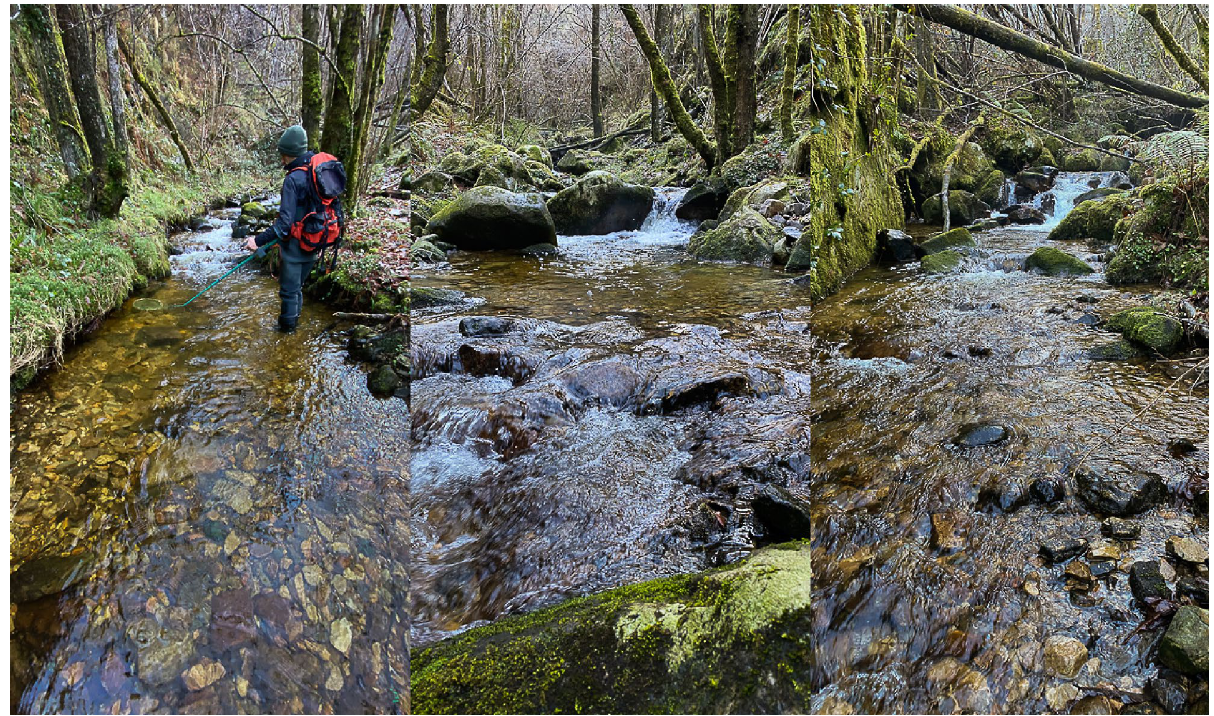
Figure 6. Examples of the experimental sections in Santianes River. The photographs were taken by mid- January and represent typical flow conditions during autumn and winter. Photo credit: Alfredo G.